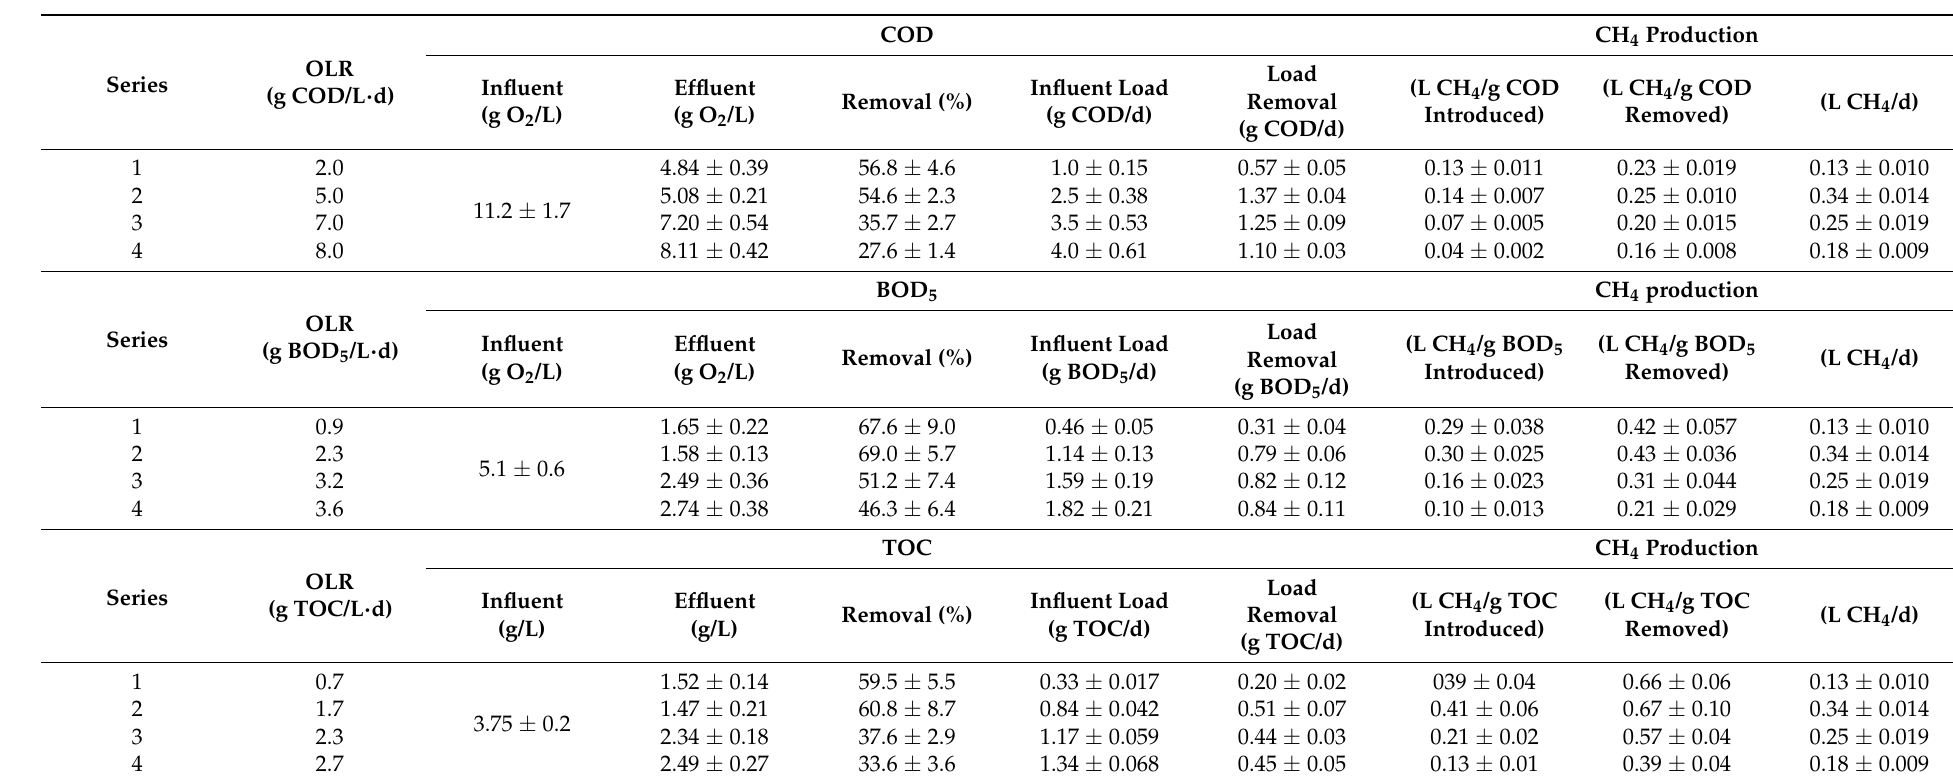
Table 5. Removal of organic compounds as COD, BOD 5 , TOC, and production of CH 4 in stage